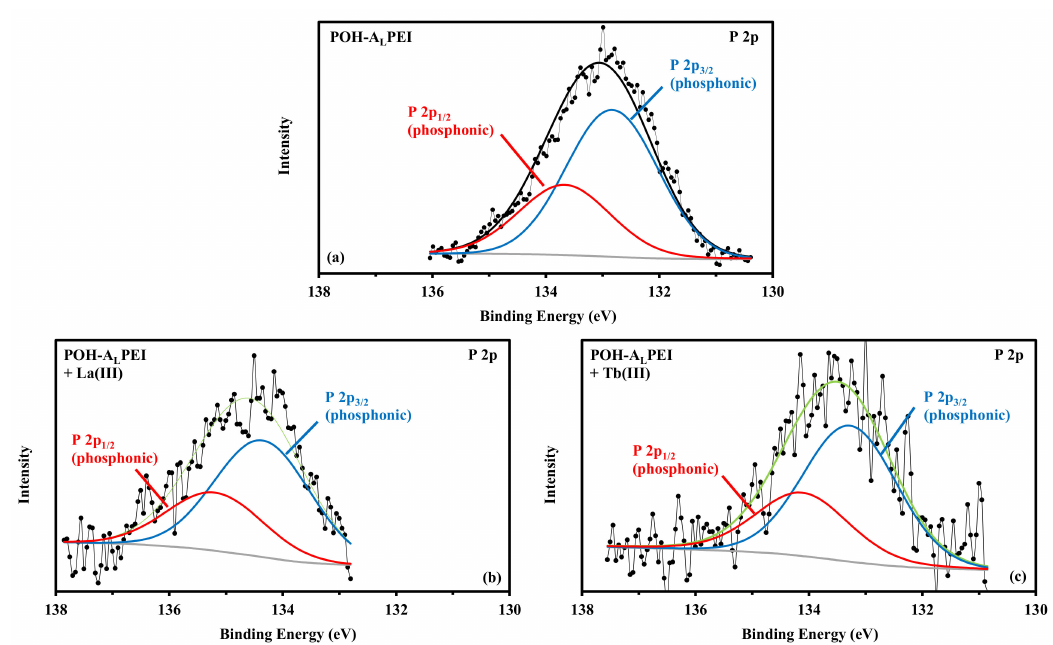
Figure 11. HRES XPS P 2 p core level spectra for POH-A L PEI before ( a ) and after metal sorption (La (III): ( b ); Tb (III): ( c )).